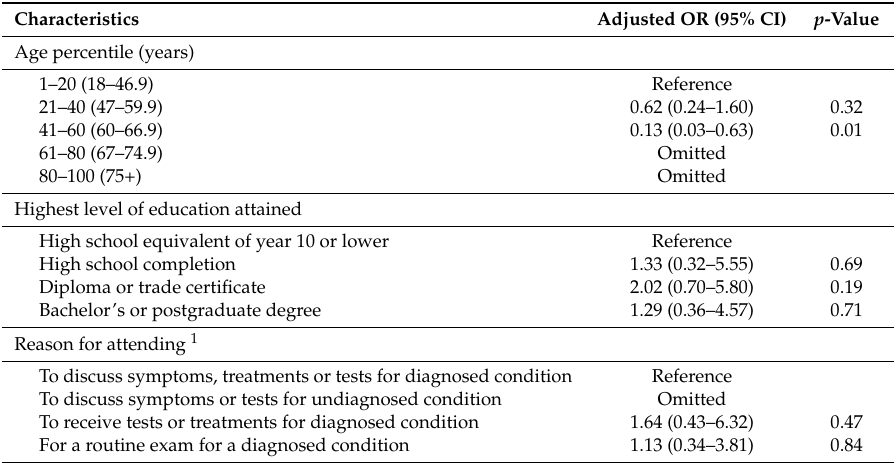
Table 6. Adjusted odds of selecting “Access to information and assistance for insurance, work leave and